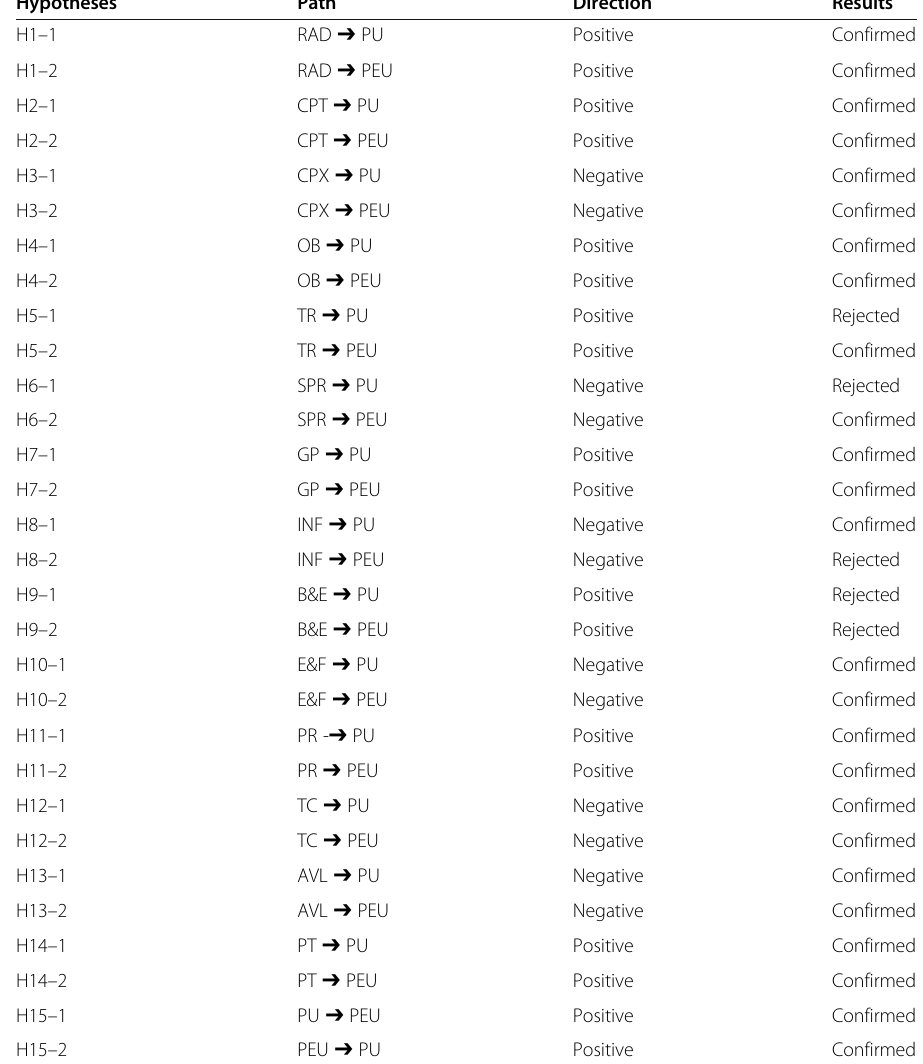
Table 1 Structural path analysis